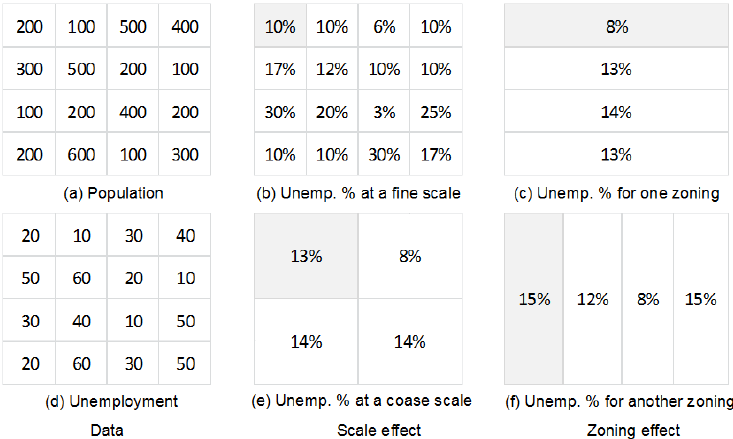
Figure 4. Illustration of the MAUP using unemployment rate as an example. Note: Data, and scale and zoning effects are shown in panels ( a–f ). The original data shown are in panels (a,d), while the derived percentages in panels (b,c,e,f). For example, the four percentages in the shaded cells are as follows: 10% = 20/200, 8% = (20 + 10 + 30 + 40)/(200 + 100 + 500 + 400), 13% = (20 + 10 + 50 + 60)/(200 + 100 + 300 + 500), and 15% = (20 + 50 + 30 + 20)/(200 + 300 + 100 + 200).